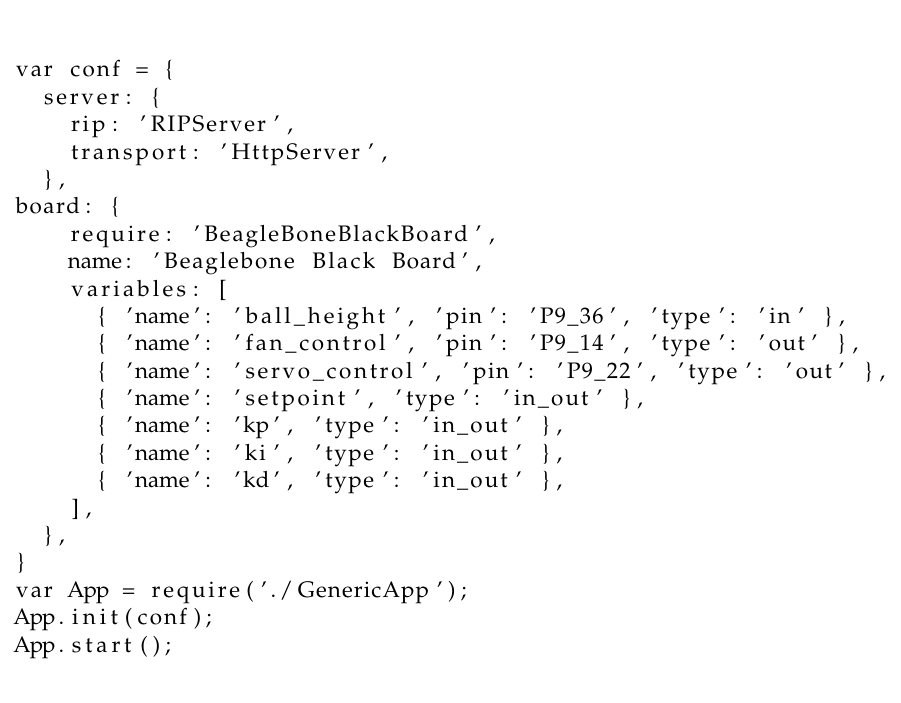
Figure 4. Configuration